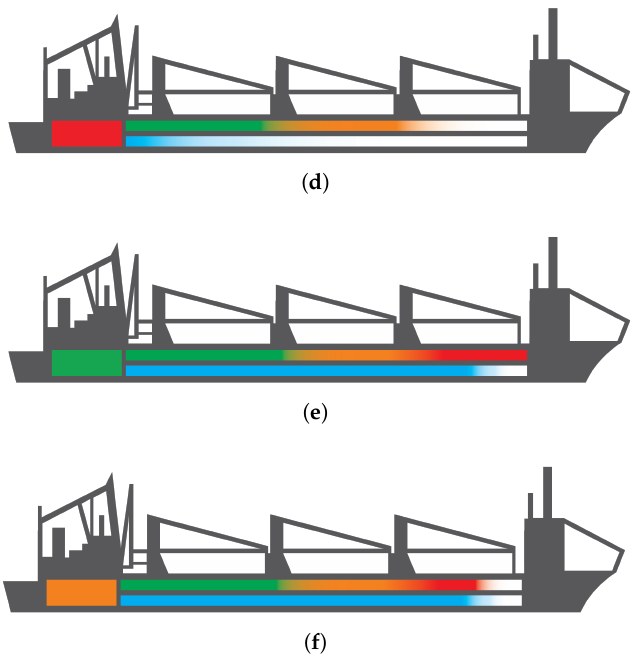
Figure 8. Typical graphical tags of the ship environmental performance. ( a ) Ship with good en- vironmental performance, average physical dimensions, operating mostly inside Member State’s jurisdiction. ( b ) Ship with good environmental performance, large physical dimensions, operating mostly inside Member State’s jurisdiction. ( c ) Ship with very good environmental performance, aver- age physical dimensions, operating mostly inside Member State’s jurisdiction. ( d ) Ship with average environmental performance, small physical dimensions, operating mostly outside Member State’s jurisdiction. ( e ) Ship with pure environmental performance, large physical dimensions, operating mostly inside Member State’s jurisdiction. ( f ) Ship with pure environmental performance, large physical dimensions, operating both inside and outside Member State’s